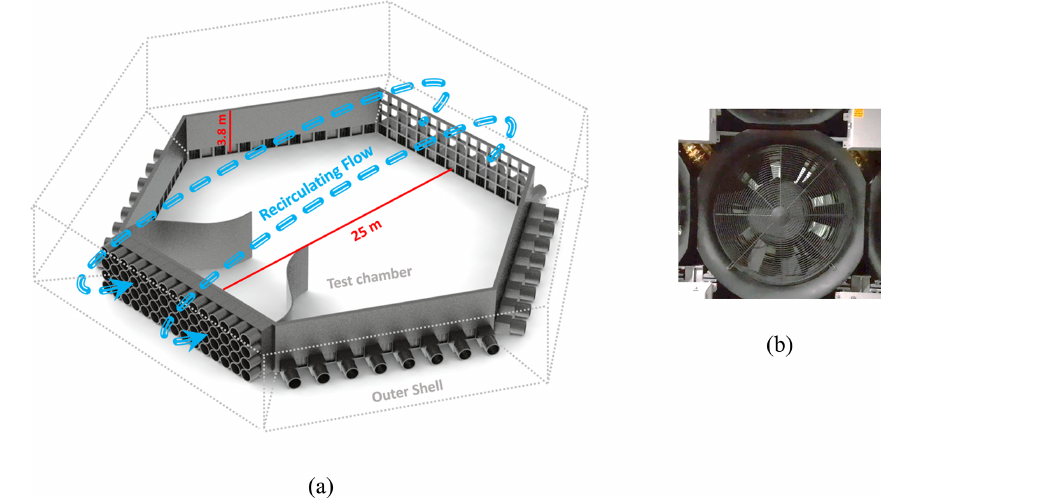
Figure 2. WindEEE dome, (a) the test chamber and the contraction walls with the flow recirculation path through the outer shell in closed- circuit 2D flow mode, and (b) the adjustable vanes at the inlets of the 60 fans at 70% opening vane state.